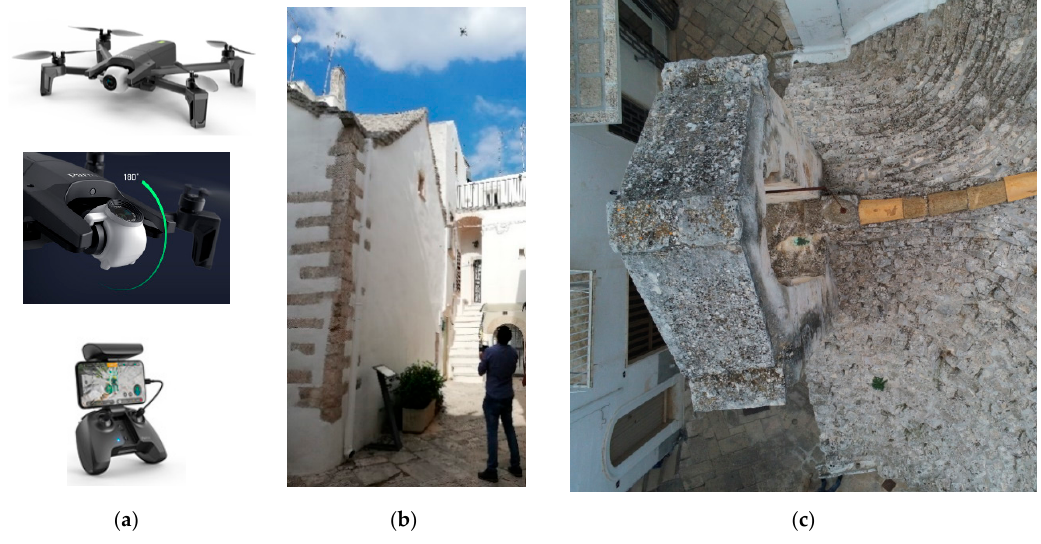
Figure 5. Image acquisition by unmanned aerial vehicle (UAV): ( a ) Parrot Anafi and Parrot Sky- controller; ( b ) acquisition step; ( c ) an aerial image acquired by UAV